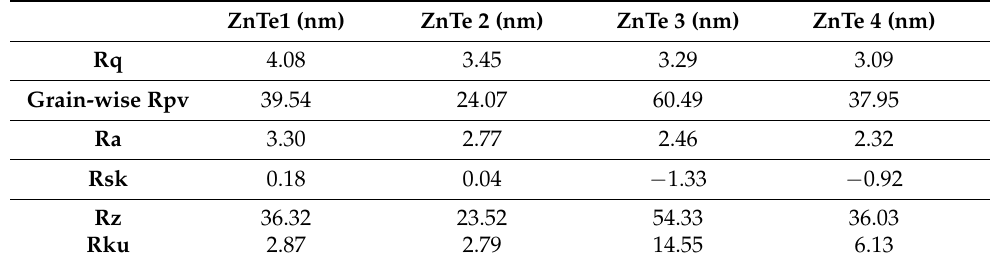
Table 2. Calculated roughness parameters on surface